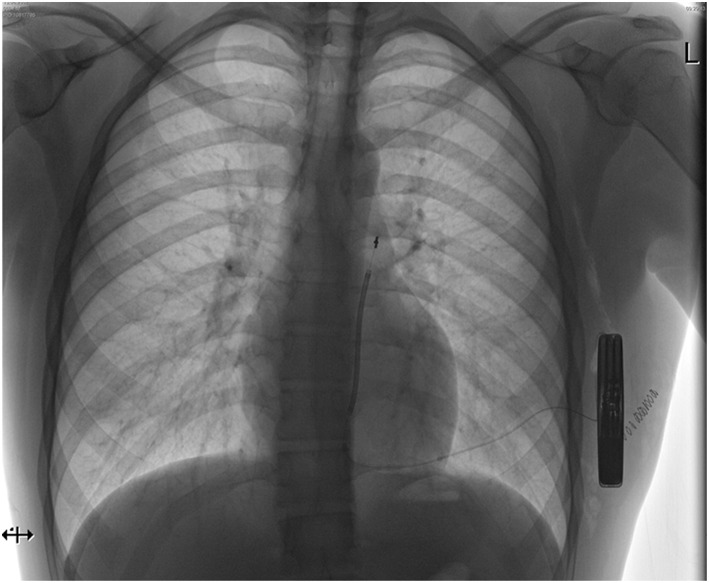
Antero-posterior chest X-ray after subcutaneous ICD (S-ICD) implantation.